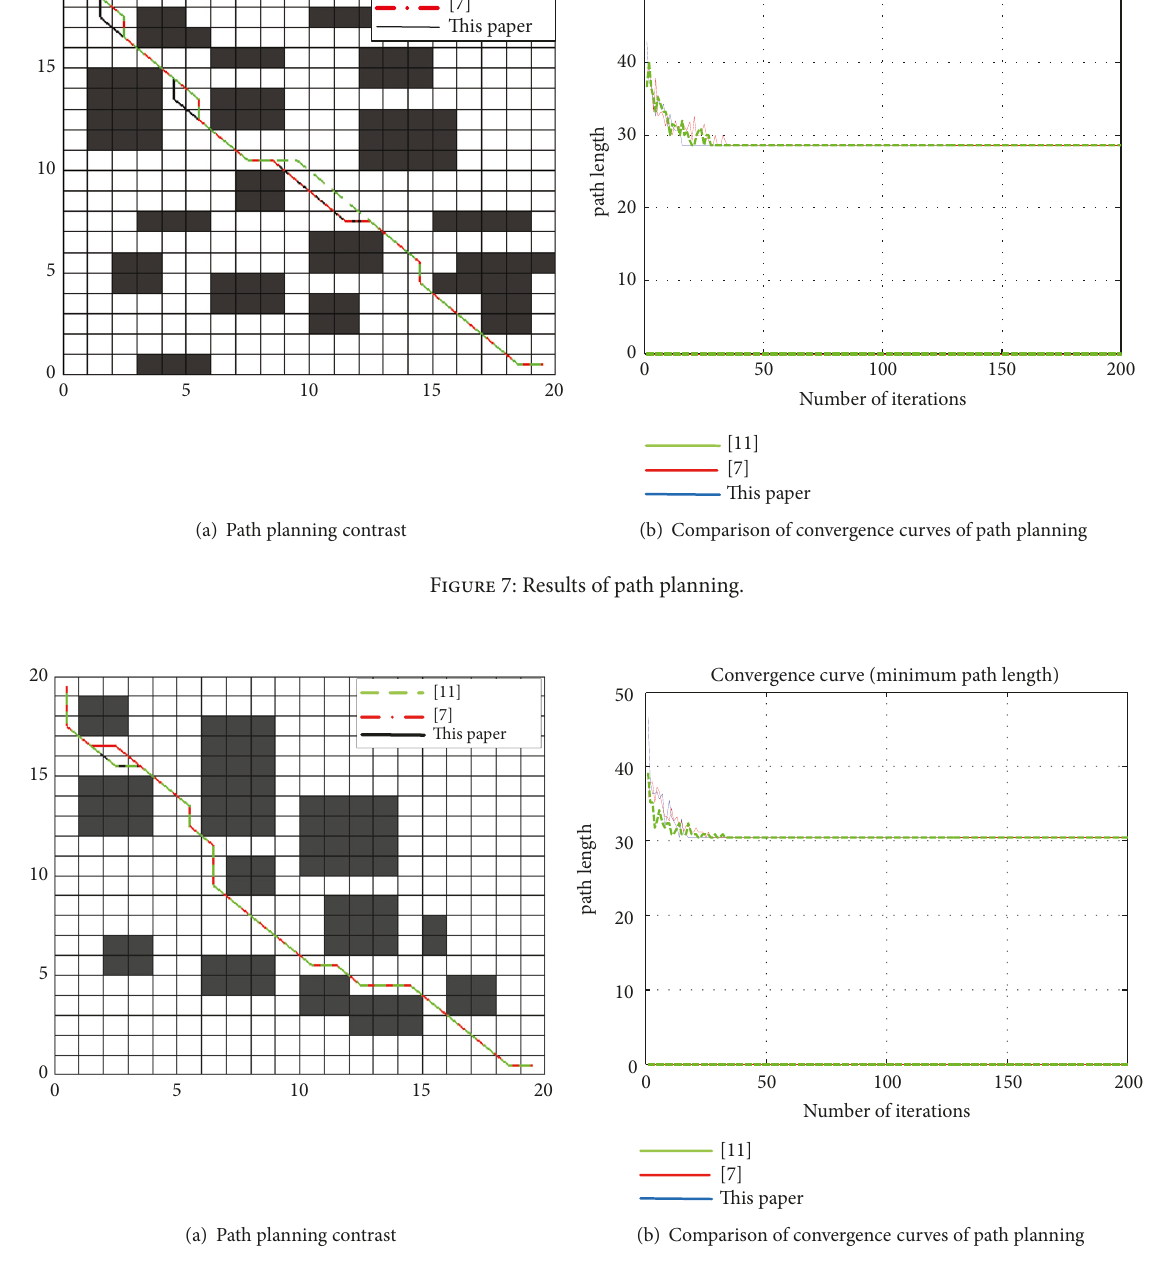
Figure 8: Results of path